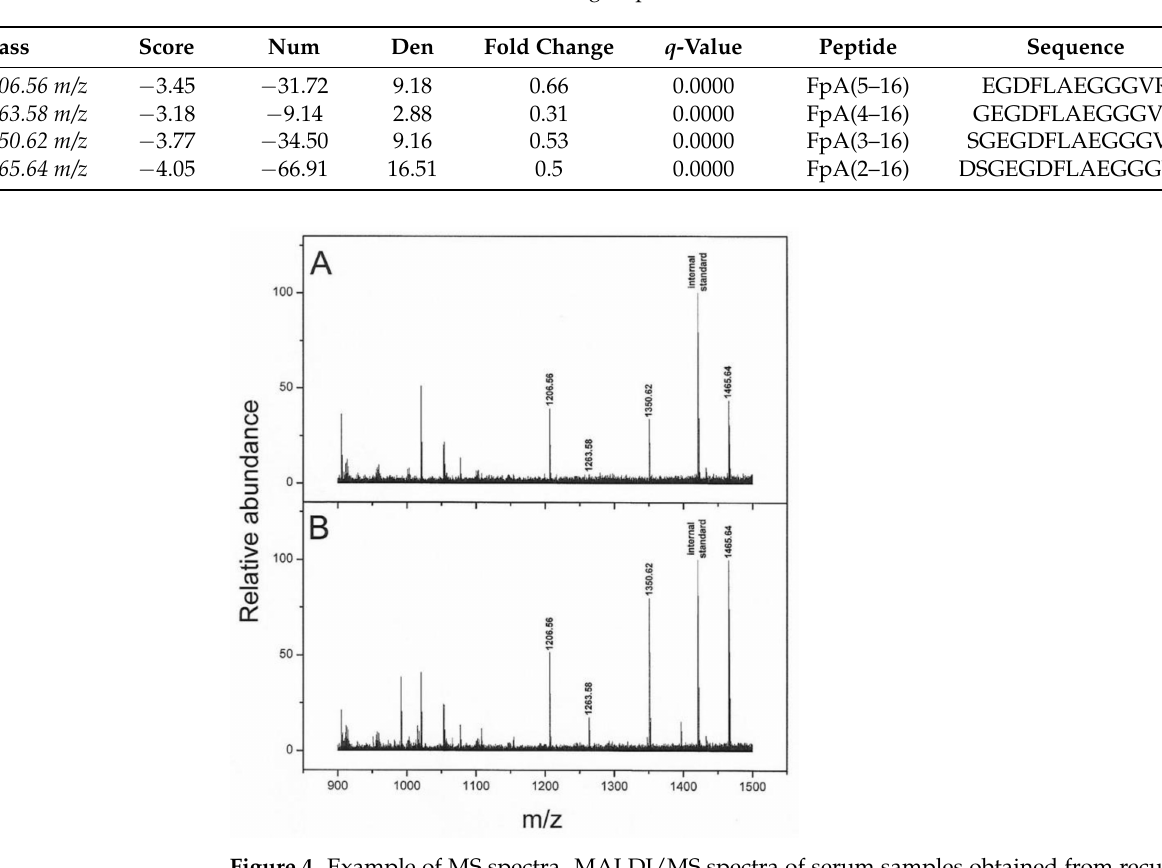
Table 5. Results of the SAM analysis for the comparison between relapsed and non-relapsed patients. Only significant signals having q -value < 5%, are reported. The SAM Score corresponds to a t statistic. Columns Num and Den report the values of the numerator and denominator of the fraction calculated by the method for determining the Score. A negative Score, as well as a Fold change < 1, highlights a decrease in the values in the second group.